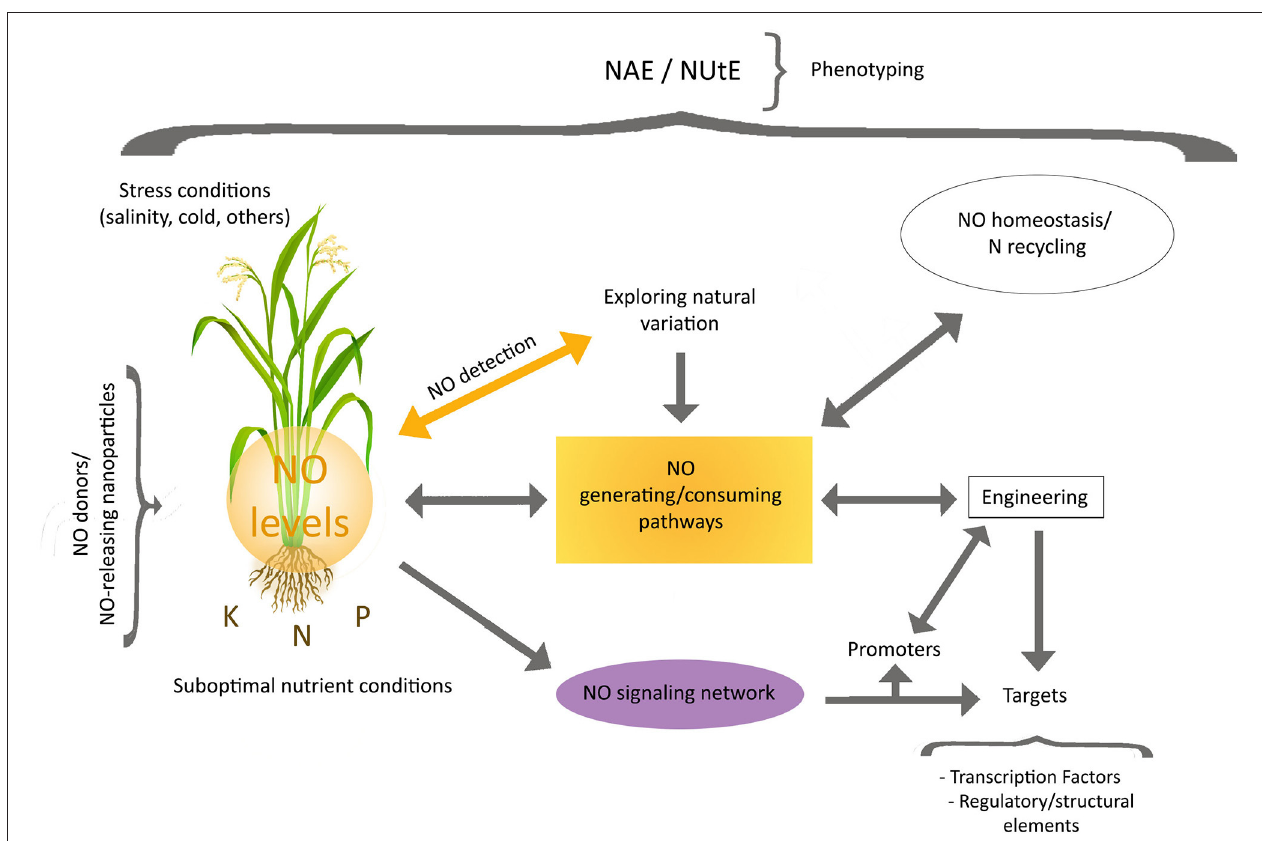
FIGURE 1 | Toward the use of NO signaling and metabolism for NUE improvement. Future research directions should include the dissection of the routes controlling local NO levels and NO signaling associated with suboptimal nutrient supply. Studies focusing on natural variation in NO balance and signaling, as well as adequate measurements of NUtE and NAE, will be needed. Engineering of localized NO signals (through NO generating/consuming proteins), NO homeostasis and associated N recycling as well as NO targets, will be also necessary for the development of potential strategies leading to NUE enhancement while reducing possible by-side effects. The identification of transcription factors and structural proteins acting in the NO signaling network, under suboptimal specific nutrient stress conditions, will provide additional tools for the development of new engineering procedures. Stress conditions hampering growth and nutrient homeostasis should be also taken into consideration. The precise impact of strategies based on the use of NO donors/NO-releasing particles must be